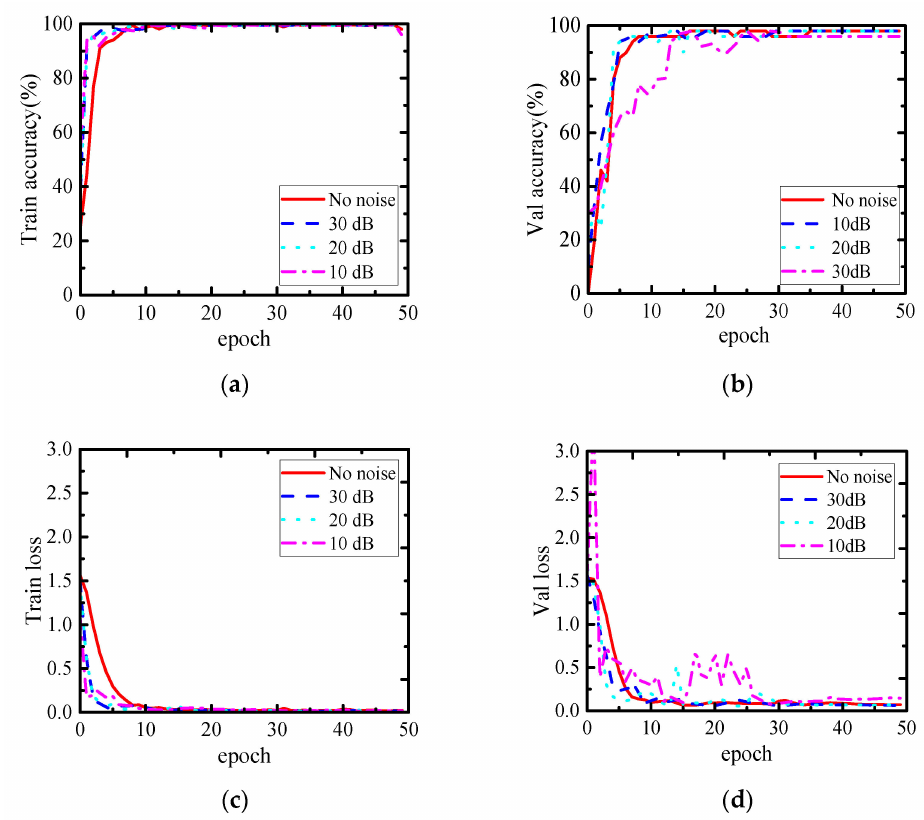
Figure 14. Results of vehicle weights identification under different noise levels: ( a ) Training accuracy curves of response samples; ( b ) Validation accuracy curves of the response samples; ( c ) Training loss curves of the response samples; ( d ) Validation loss curves of response samples.